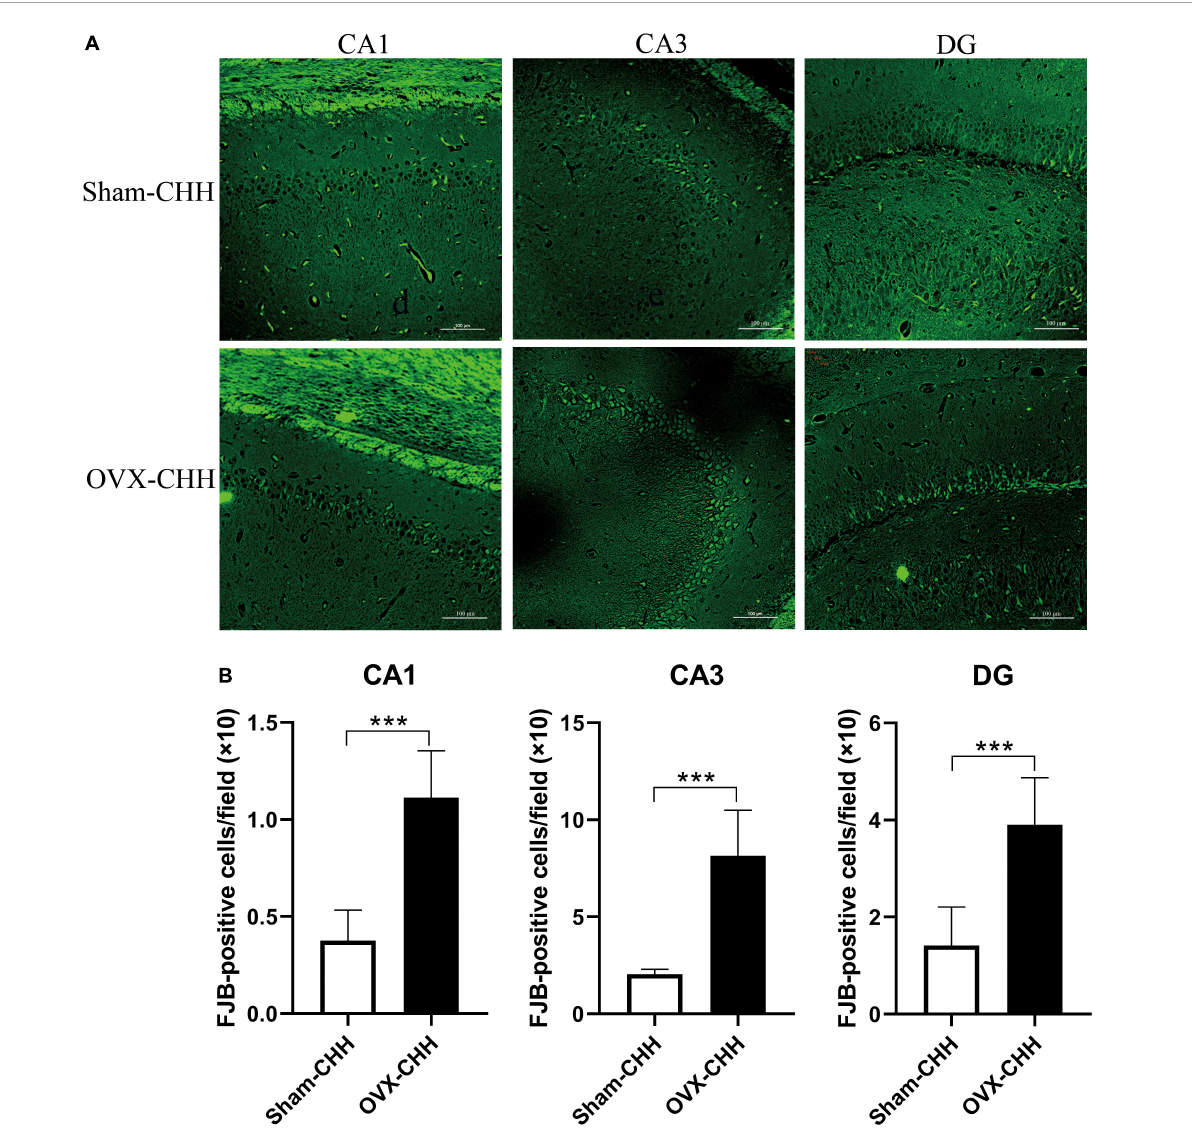
FIGURE12 Chronic hypobaric-hypoxia exposure for 3 months, OVX showed more obvious hippocampal neuron death than intact females. (A) Representative immunofluorescence images of FJB staining in different hippocampal subregions (CA1, CA3, DG) (20 × ), Scale bar = 100 µ m; (B) statistical analysis of FJB positive cells in different hippocampal subregions (CA1, CA3, DG). OVX, bilateral ovariectomy. Values are means ± SD for six animals/group. Compared with sham CHH, * p < 0.05, ** p < 0.01, *** p <